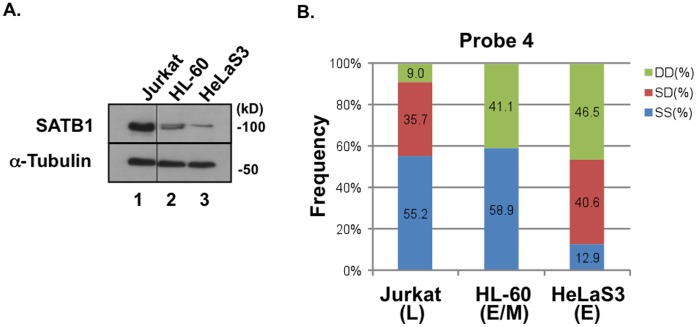
Correlation between SATB1 expression and replication timing at TTR.
A. SATB1 expression in Jurkat, HL-60 and HeLaS3. Whole cell extracts, separated on 7.5% SDS-polyacrylamide gel, were blotted with anti-SATB1 antibody. Expression of SATB1 is high in T cell (Jurkat), and low or non-detectable in non-T cells (HL-60 and HeLaS3). B. Replication timing of the Probe 4 (see Fig. 2B and Table S1) in Jurkat, HL-60 and HeLaS3. This locus replicates in late-S in Jurkat (high SATB1) and in early-S in HL-60 (low SATB1) and HeLaS3 (very low SATB1).